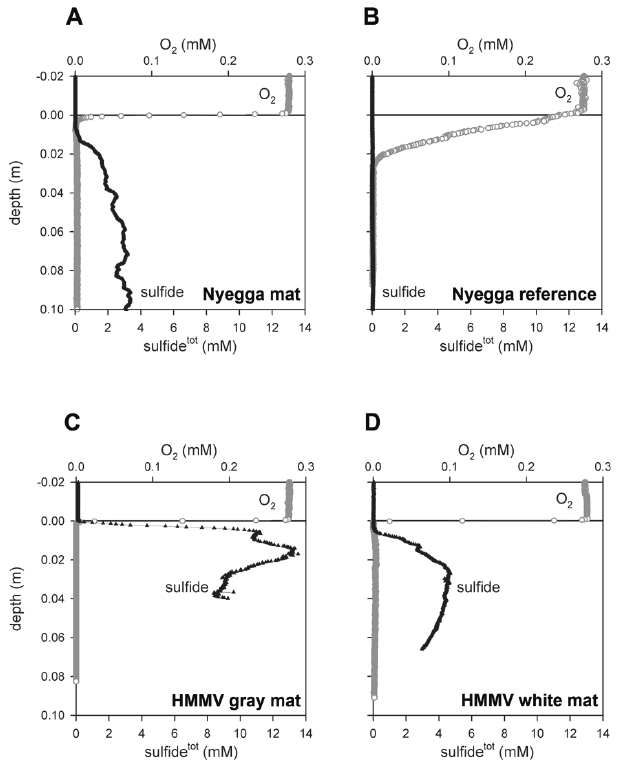
Fig. 5. High-resolution in situ microprofiles of oxygen (O 2 ) and sul- fide (sulfide tot = H 2 S+HS − +S 2 − ) recorded (A) on a Nyegga gray mat in the vicinity of pockmark G12, (B) on reference sediment between pockmark G11 and G12, (C) on a H˚akon Mosby mud vol- cano (HMMV) gray mat, and (D) on a HMMV white mat ( C and D modified from Lichtschlag et al., 2010). Oxygen and sulfide fluxes corresponding to the different profiles are listed in Table